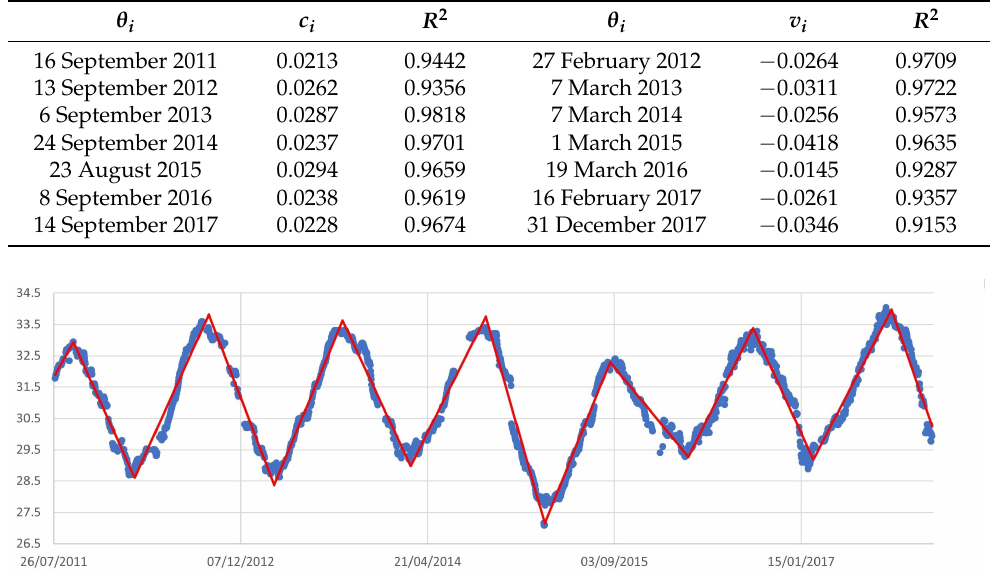
Table 3. Estimated slopes c i and v i and corresponding coefficients of determination evaluated for